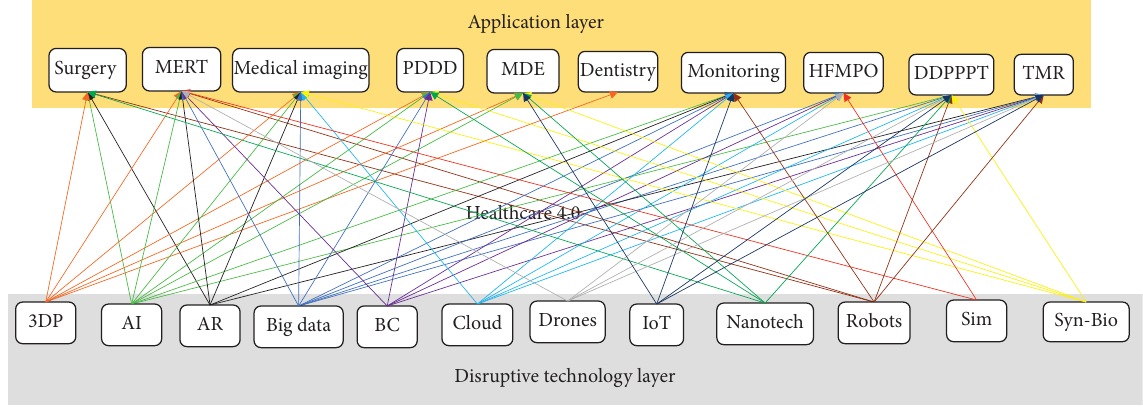
Figure 8: The convergence of disruptive technologies in healthcare.